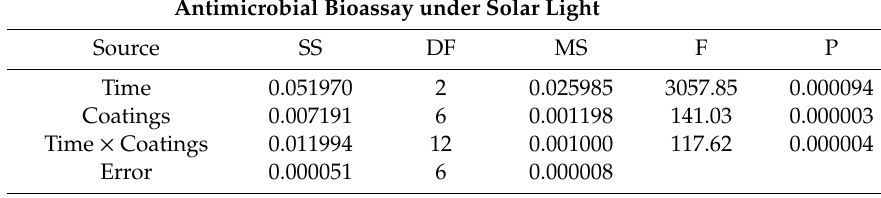
Figure 8. Abundance of B. subtilis on SS/C-N-TiO 2 , SS/Ti(N, O)/C-N-TiO 2 and SS/Cr-N/Cr(N, O)/C-N-TiO 2 coatings and uncoated stainless steel (control) in dark ( a ) and light ( b ) after 0, 24 and 48 h. Data were means ± SD; n = 3. Table 4. ANOVA results for CFU comparisons during the antibacterial bioassay with B. subtilis in solar light and dark obtained with SS/C-N-TiO 2 , SS/Ti(N, O)/C-N-TiO 2 and SS/Cr-N/Cr(N, O)/C-N-TiO 2 and uncoated stainless steel (control) at varied experimental times 0, 24 and 48 h (SS–sum of squares; DF–Degrees of freedom; MS–mean of squares; F–F-statistic; P–probability).